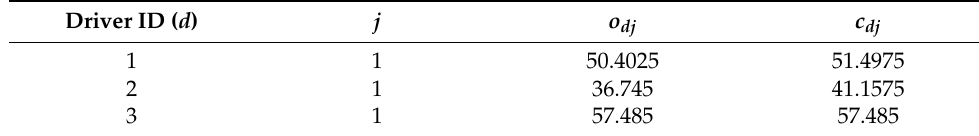
Table 7. Price information in the bids submitted by drivers.